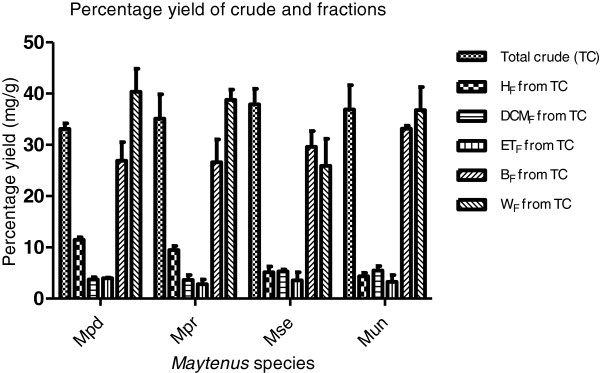
Yield of crude extract and fractions. Mpd = Maytenus peduncularis, Mpr = Maytenus procumbens, Mse = Maytenus senegalensis, Mun = Maytenus undata, TC = total crude, HF = hexane fraction, DCMF = dichloromethane, ETF = ethyl acetate, BF = butanol fraction, WF = water fraction.